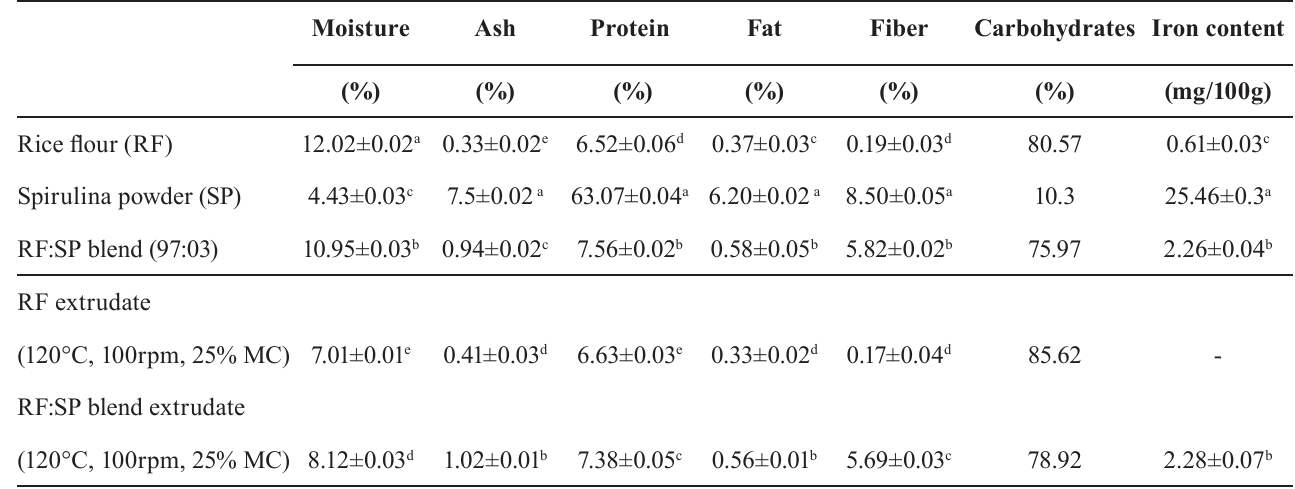
TABLE I - E ffect of addition of Spirulina on nutritional propertiesof raw formulations and extrudates prepared under